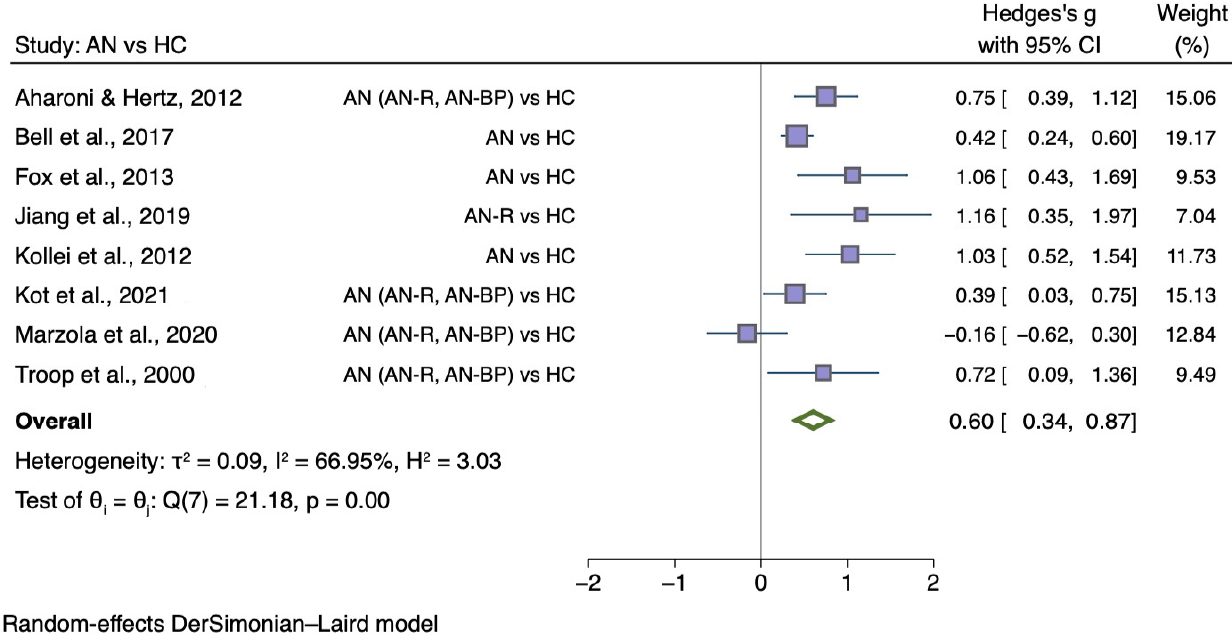
Figure 4. Forest plots of Hedges’ g in generic disgust sensitivity between AN participants and HCs from n = 8 studies; CI: confidence interval. Refs. [27,32–35,37,38,54].